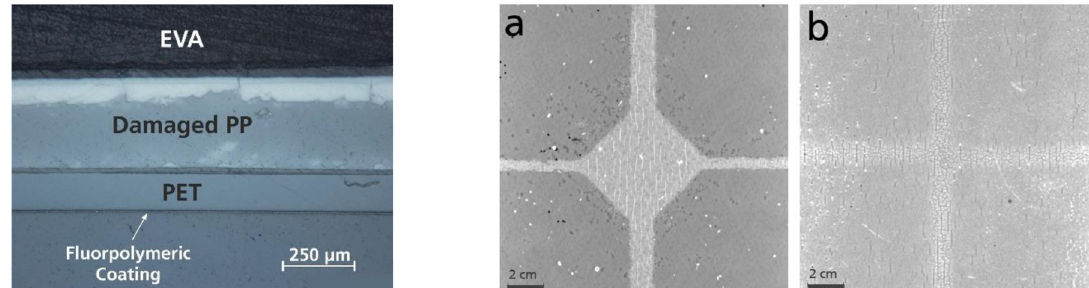
Fig. 6. Left: Cross section of a F-C/PET/PP coating with damaged PP layer. Right: Acoustic images of the multilayer backsheets in a fi eld-exposed PV module; (a) core/inner layers interface of F-C/PET/PP backsheet; (b) outer/core layers interface of PA/PET/PA